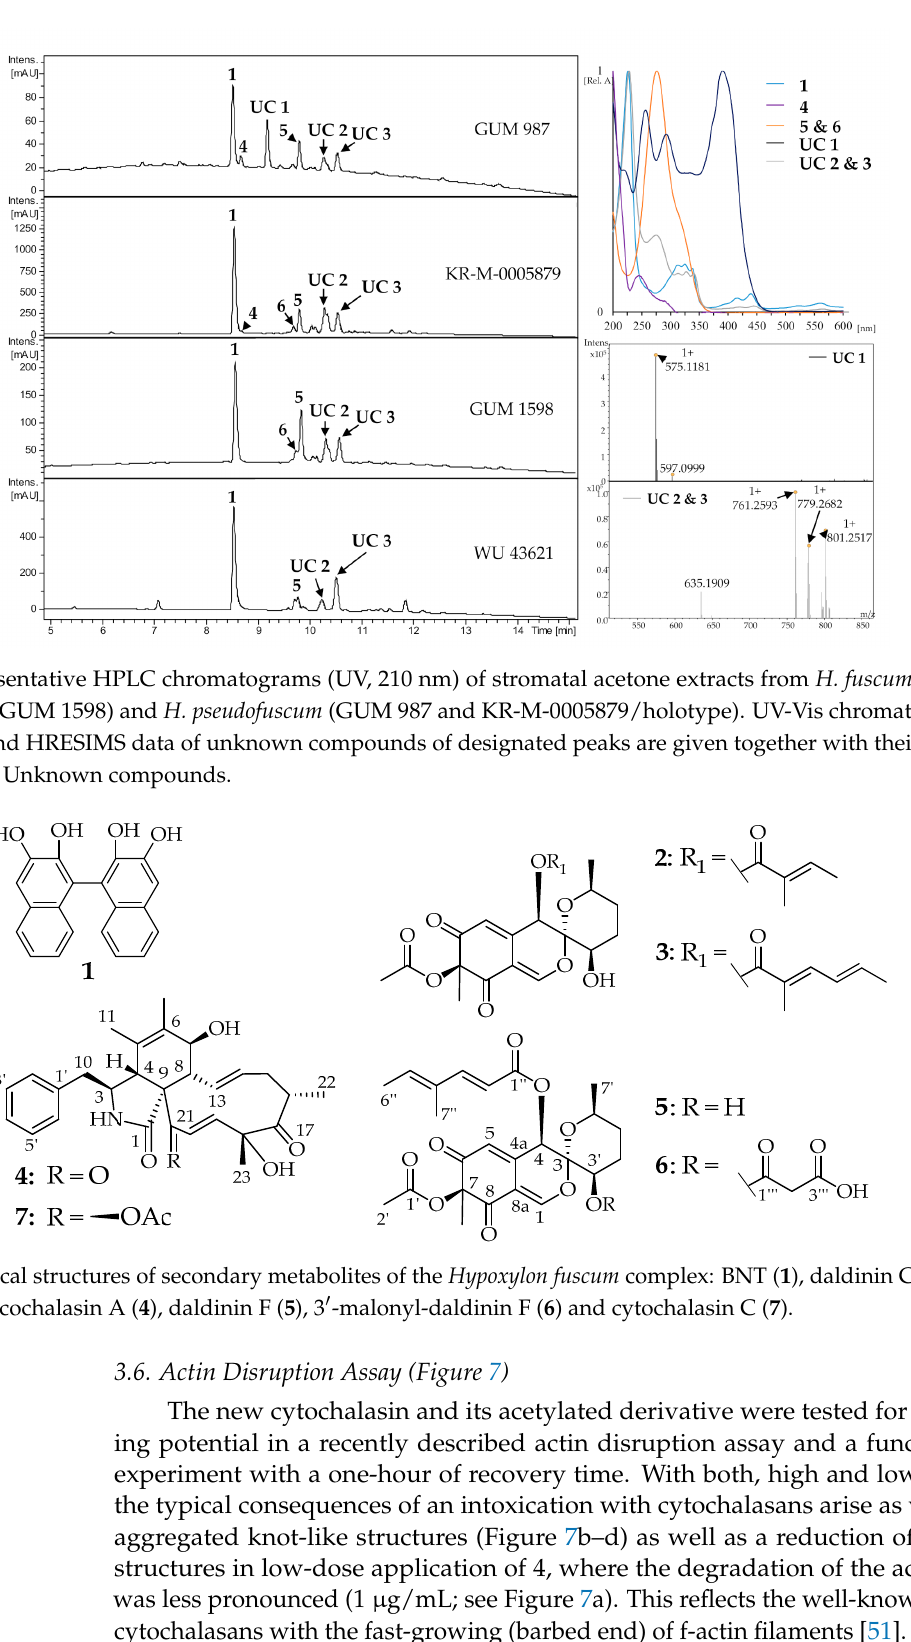
Figure 6. Chemical structures of secondary metabolites of the Hypoxylon fuscum complex: BNT ( 1 ), daldinin C ( 2 ), daldinin E ( 3 ), pseudofuscochalasin A ( 4 ), daldinin F ( 5 ), 3 ′ -malonyl-daldinin F ( 6 ) and cytochalasin C ( 7 ).